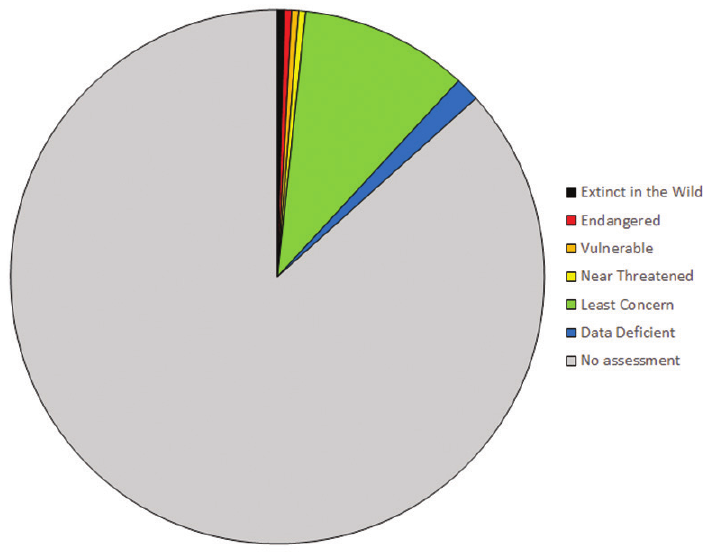
Figure 1. IUCN conservation assessments of the medicinal plant species treated in this study (IUCN